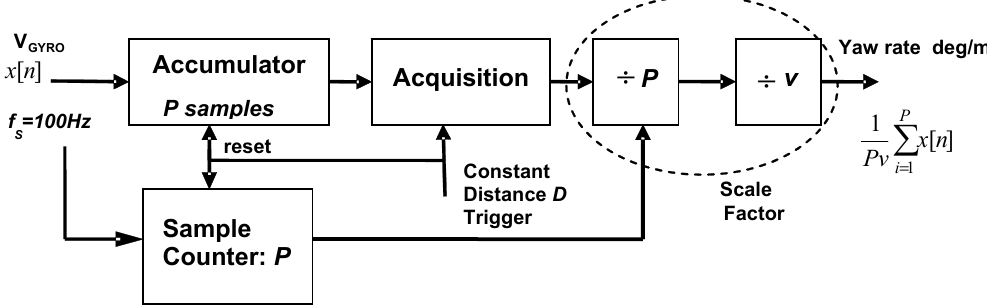
Figure 9. Distance sampler accumulator including train velocity scaling